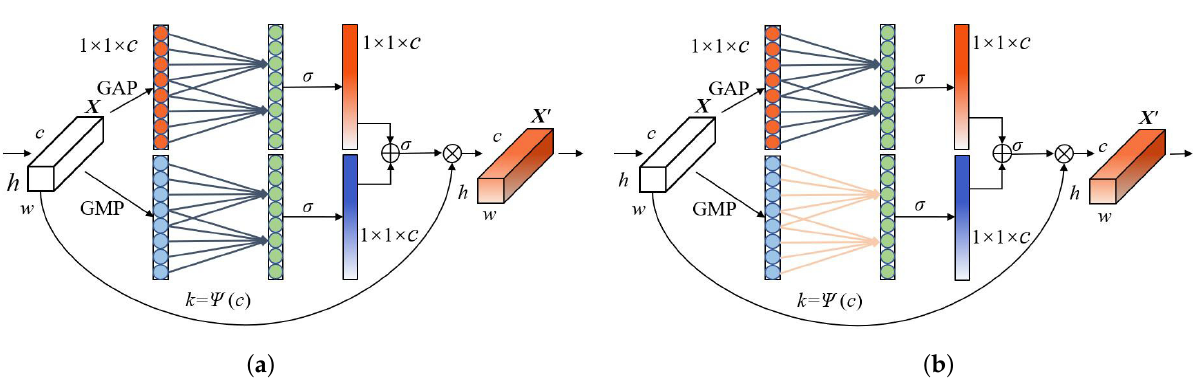
Figure 6. Improved ECA. ( a ) GAP share weights with GMP (ECA-WS); ( b ) GAP and GMP weight independent